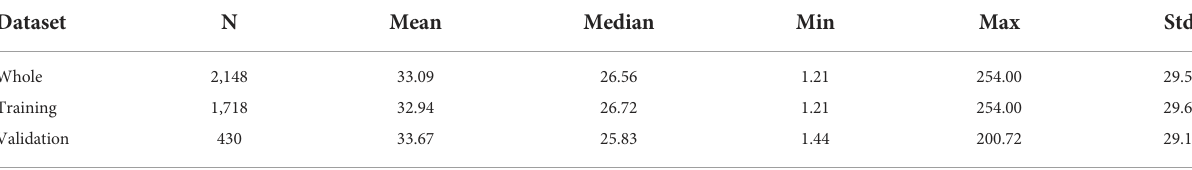
TABLE 1 Statistical descriptions of PON concentrations for all matchups (whole), model training (four- fi fth of matchups), and validation (one- fi fth of matchups) datasets, respectively. Dataset